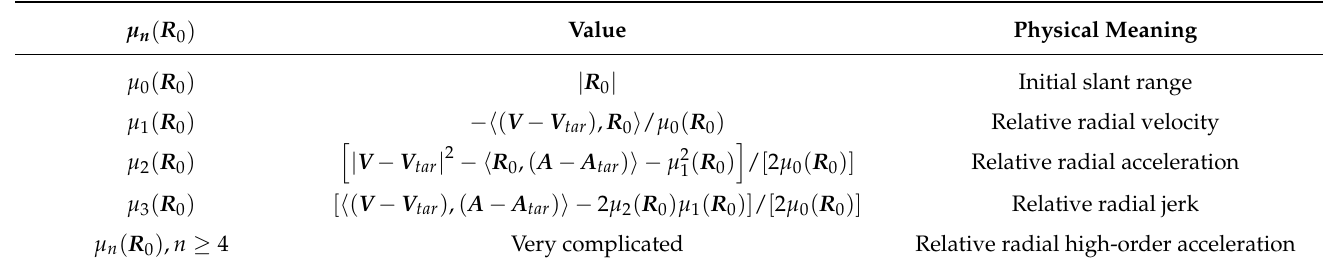
Table 1. Values and physical meanings for µ n ( R 0 )